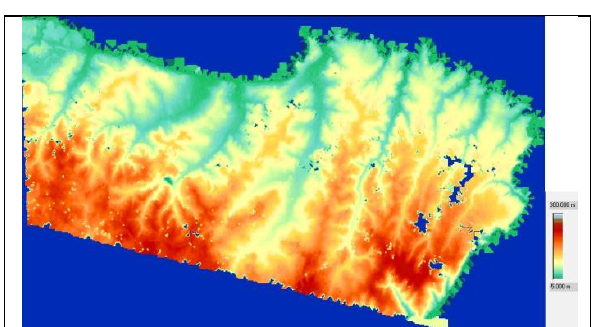
Fig. 11: color coded DEM, part B